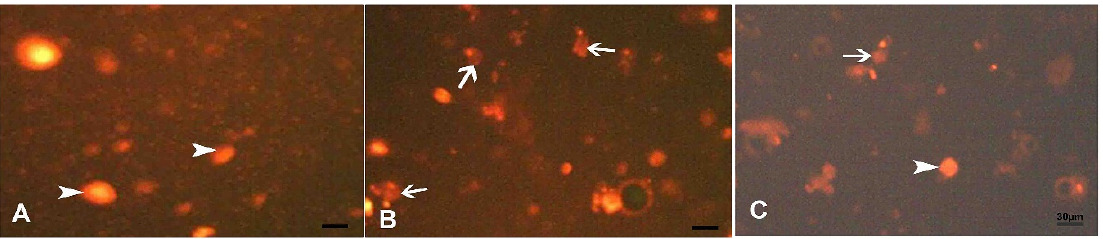
Table 1. The area percent of anti-4-HNE immune stained sections in different groups.